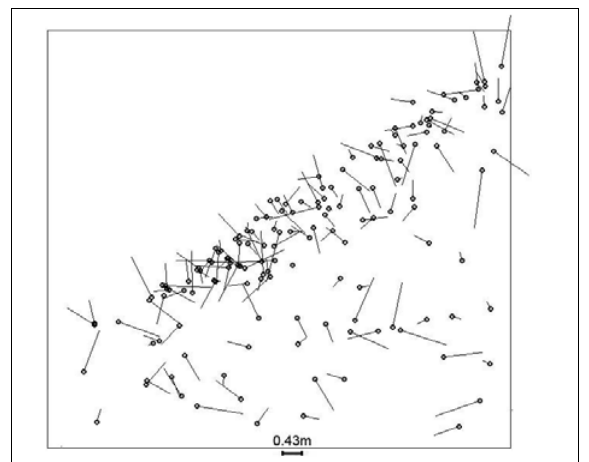
Figure 4. Discrepancies at control points X, Y, centre image